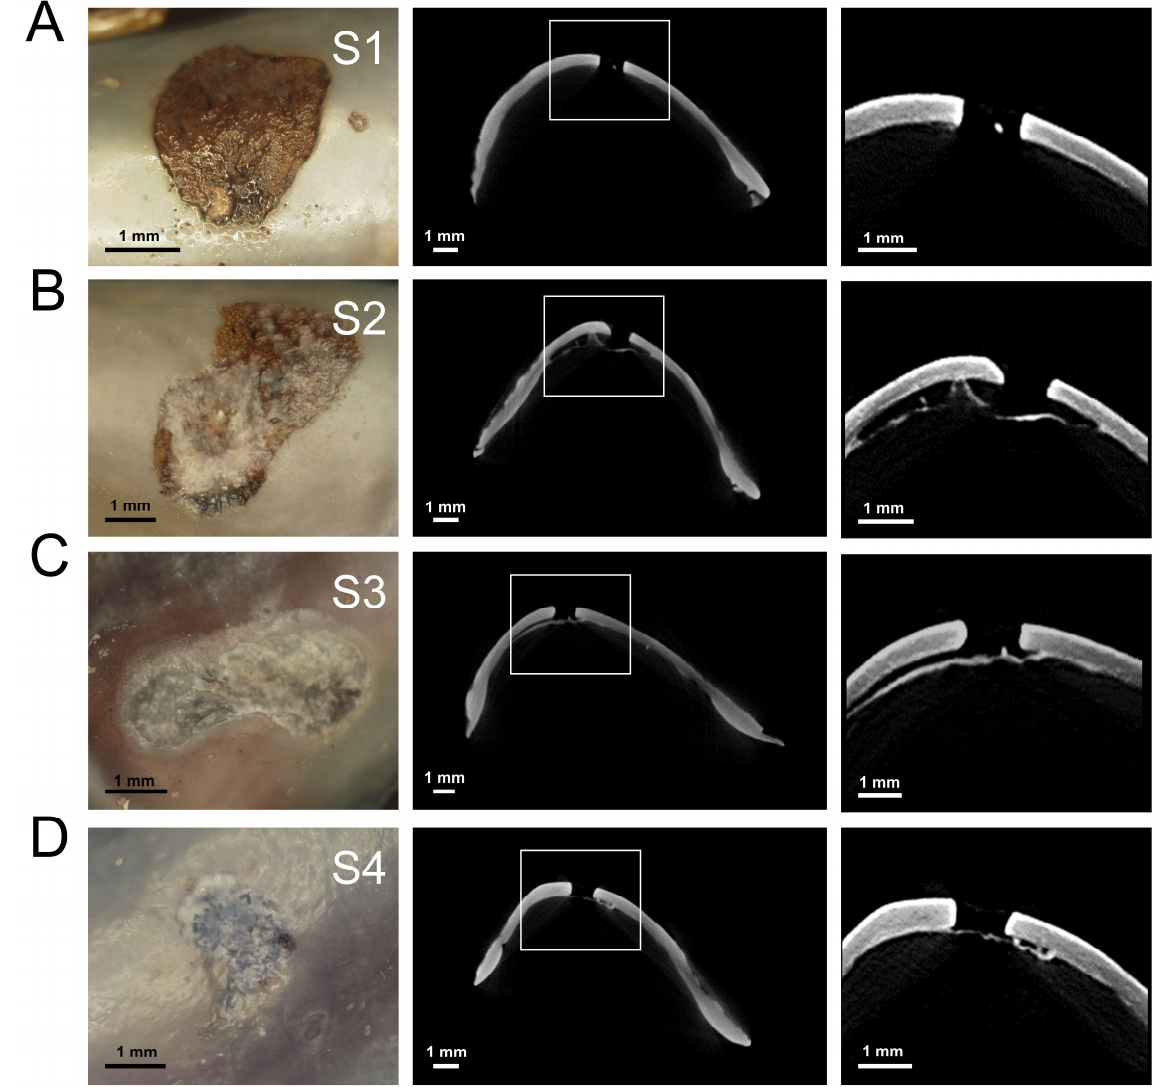
Figure 5. Representative photographs and µ CT images of repaired drill holes at Stage 1 (S1; ( A )), Stage 2 (S2; ( B )), Stage 3 (S3, ( C )), and Stage 4 (S4, ( D )). Images are from mussels within laboratory experiments ( M. trossulus ; 400 µatm p CO 2 ). Table 1. Measured seawater carbonate parameters during OA treatments and their respective vari- ability (±1 SD). Measurement uncertainties for each parameter were as follows: temperature (T; 0.63%), salinity (S; 0.33%), pH (0.13%), and total alkalinity (A T ; 0.19%).